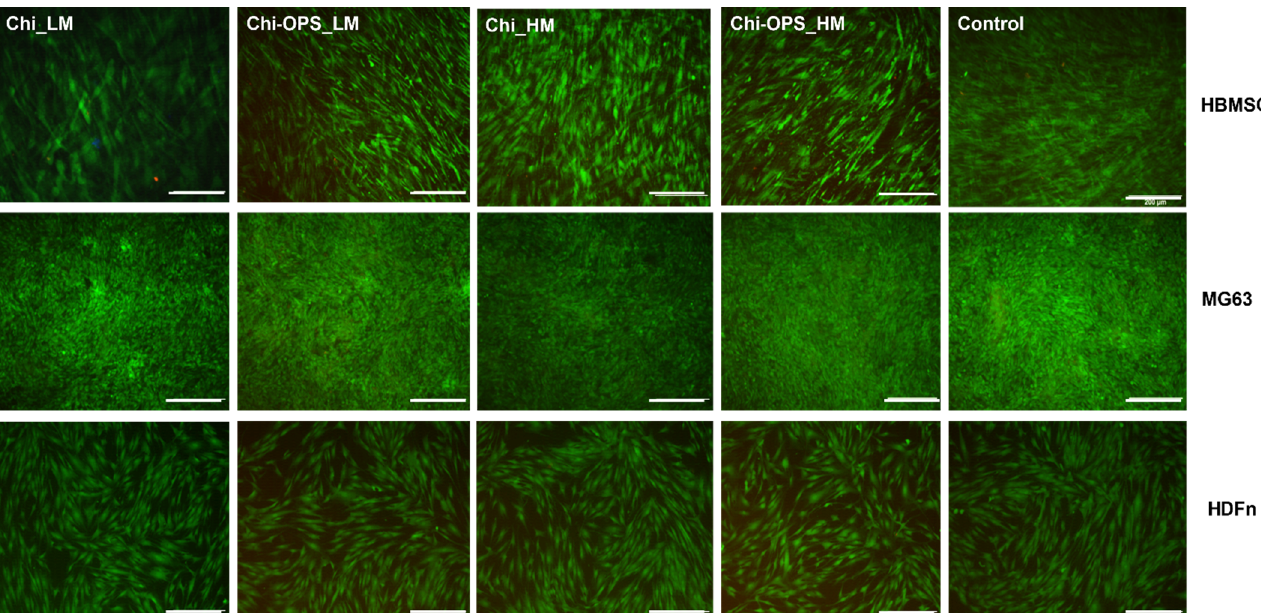
Figure 4. Live/Dead analysis for cell viability (HBMSC, HDFn and MG63) cultured for 21 days. Calcein and Propidium iodide staining in green and red, respectively. Scale bar: 200 µm.